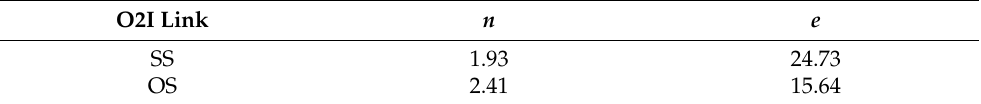
Table 4. Median Path Loss.